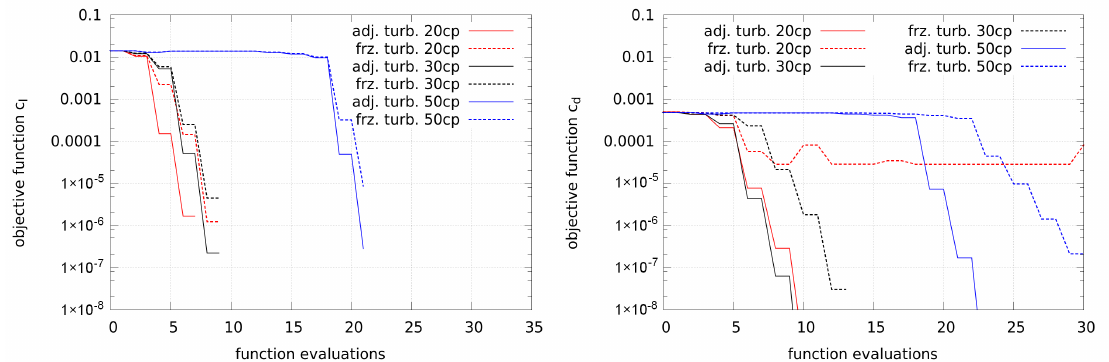
Figure 7. Objective functions for lift and drag as in Equation (14) along the number of function evaluations for the NACA 0012 at AoA = 2 ◦ . Frozen as well as adjoint turbulence are used. The number of control points is labeled as